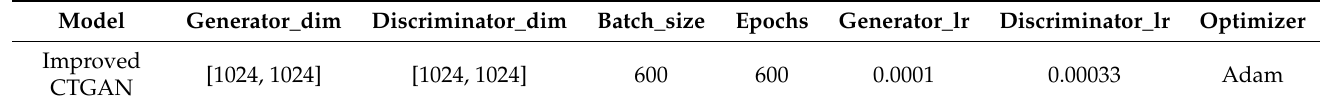
Table 1. Synthetic data generated using the improved CTGAN model’s configuration are shown